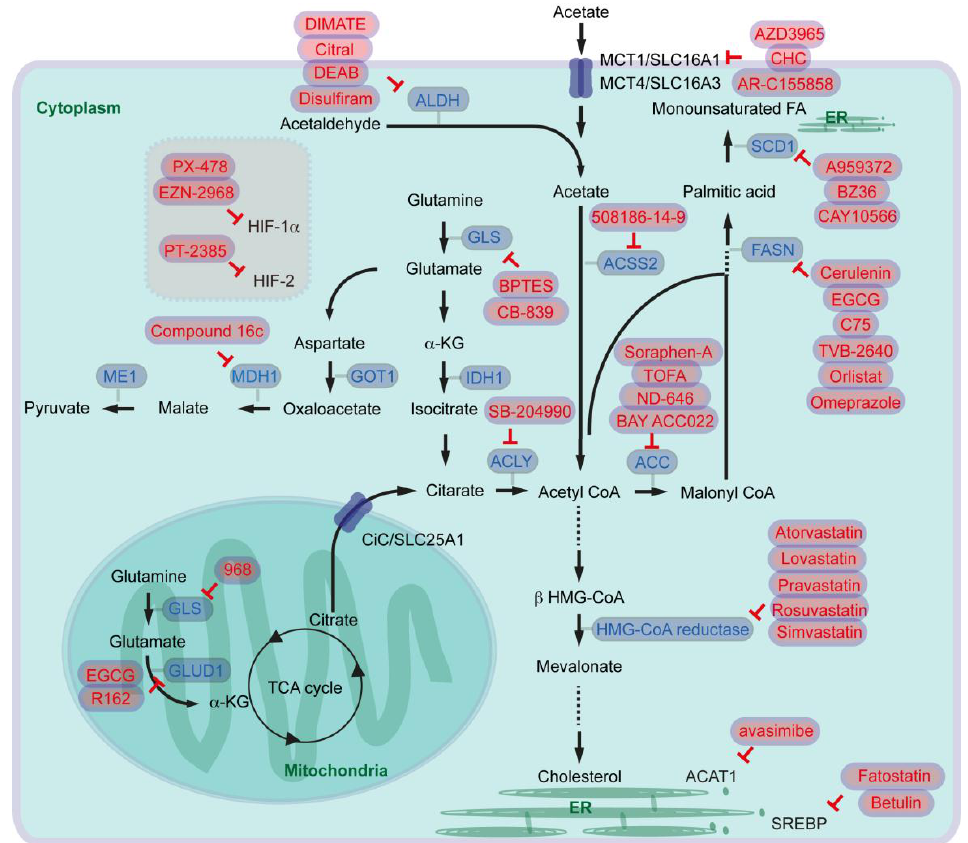
Figure 3. overview of inhibitors for targeting lipid metabolism in cancers (ACAT: acyl-CoA Figure 3. Overview of inhibitors for targeting lipid metabolism in cancers (ACAT: acyl-CoA